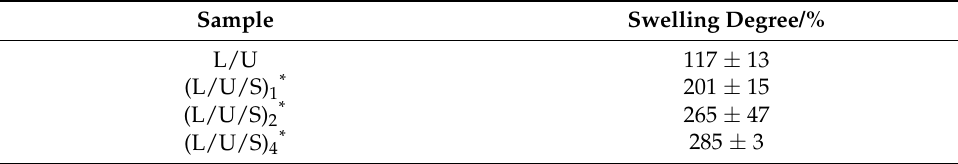
Figure 6. Mechnical Properties of different electrospun membranes: ( a ) Stress-strain curves; ( b ) Tensile strength; ( c ) Elongation; ( d ) Young’s modulus. (L/U/S) 1* , (L/U/S) 2* , (L/U/S) 4* referred to the sample after (L/U/S) 1 , (L/U/S) 2 , (L/U/S) 4 were cross-linked, respectively. * p < 0.05, ** p < 0.01, *** p < 0.001. Table 2. Swelling degree of PU/PLCL/CMCS electrospun fibers.